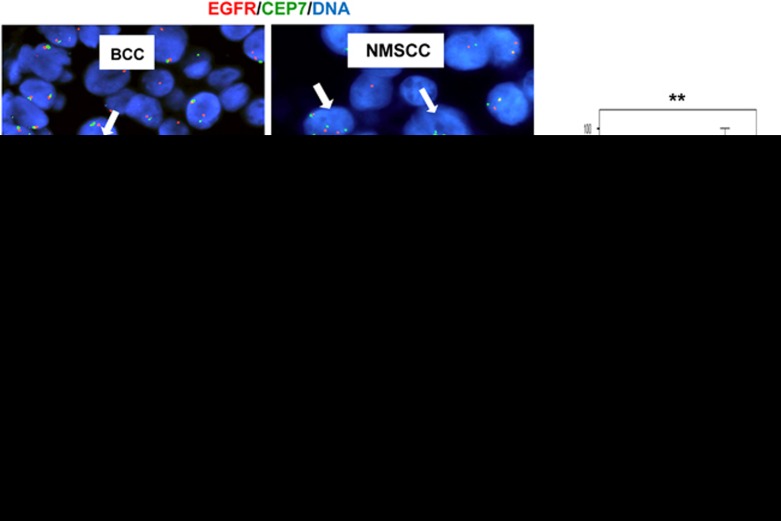
Chromosomal alterations are low in BCCs, moderate in NMSCCs and high in MSCCs. Representative microphotographs of top: in situ hybridisation (FISH) for the EGFR locus (red) and centromere of chromosome 7 (CEP7; green) in sections of BCC or non-metastatic SCC (NMSCC); bottom: NMSCC or metastatic SCC (MSCC) hybridised for EGFR (red). DAPI for DNA in blue. Scale bar, 25 μm. Histogram: percent of nuclei with EGFR amplifications (>3 spots) in BCC, NMSCC and MSCC (n as in Figure 2). Data plotted by tests Kruskal-Wallis/Mann-Whitney U. **P<0.01